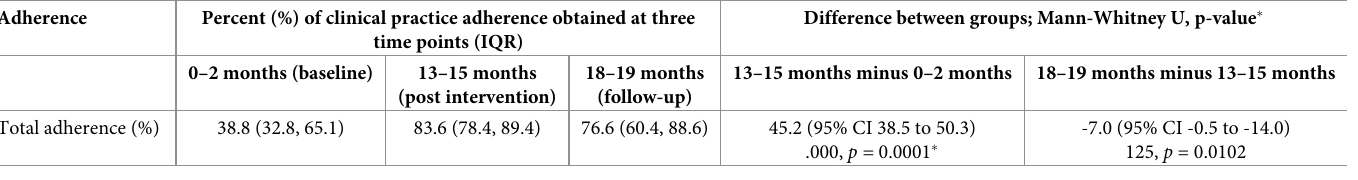
Table 4. Median (IQR) of clinical practice guideline indicator adherence across measurement points, median differences between timepoints (95% Confidence Interval) and significance of the between group difference. Adherence Percent (%) of clinical practice adherence obtained at three Difference between groups; Mann-Whitney U, p-value time points (IQR)